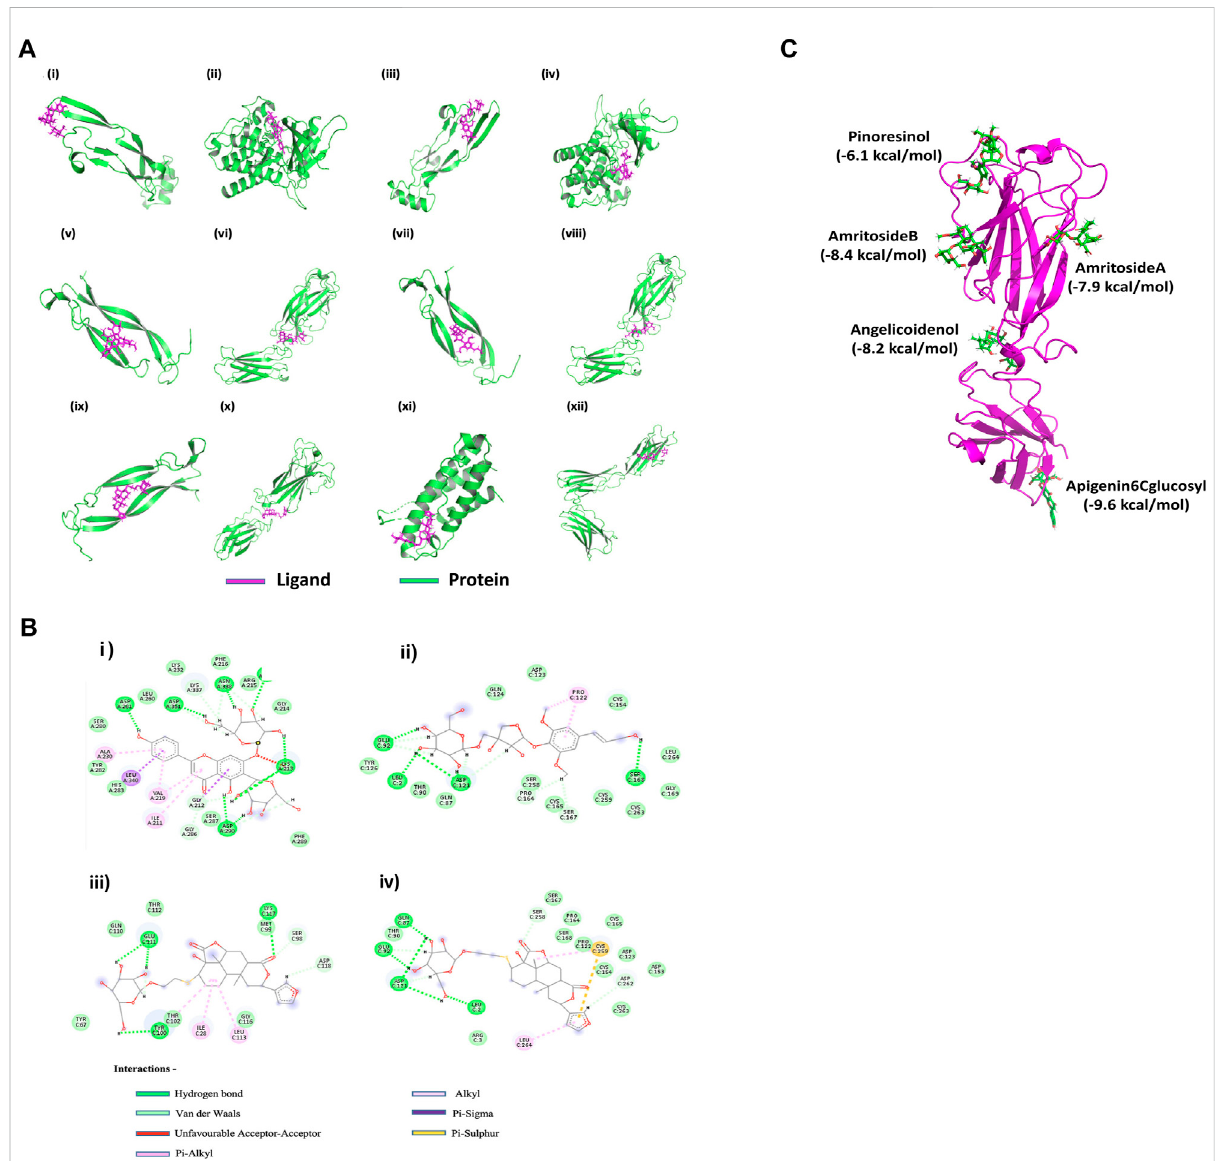
FIGURE 5 Insilicoeffectof T.cordifolia secondarymetabolitesonTh17-associatedin fl ammatorytargets (A) InteractionofthebestcompoundsApigenin- 6C-glucosyl with (i) TGF β and (ii) TGF β R, Pinoresinol with (iii) TGF β and (iv) TGF β R, Acetylasimilobine with (v) IL-17 and (vi) IL-17R, Cordifolioside-B with (vii) IL-17 and (viii) IL-17R, Cordifolide-A with (ix) IL-17, (x) IL-17R, (xi) IL-23 and (xii) IL-23R. (B) (i) Interaction plot of Apigenin-6C-glucosyl with TGF β R, (ii) Cordifolioside-B with IL-17R, (iii)Cordifolide-A with IL-17R, and (iv) Cordifolide-A with IL-23R. (C) Multiple docking ofligands (green) with fi ve different cavities of IL-17R protein (Magenta). The best compounds and their corresponding energy values in fi ve cavities are mentioned in the fi